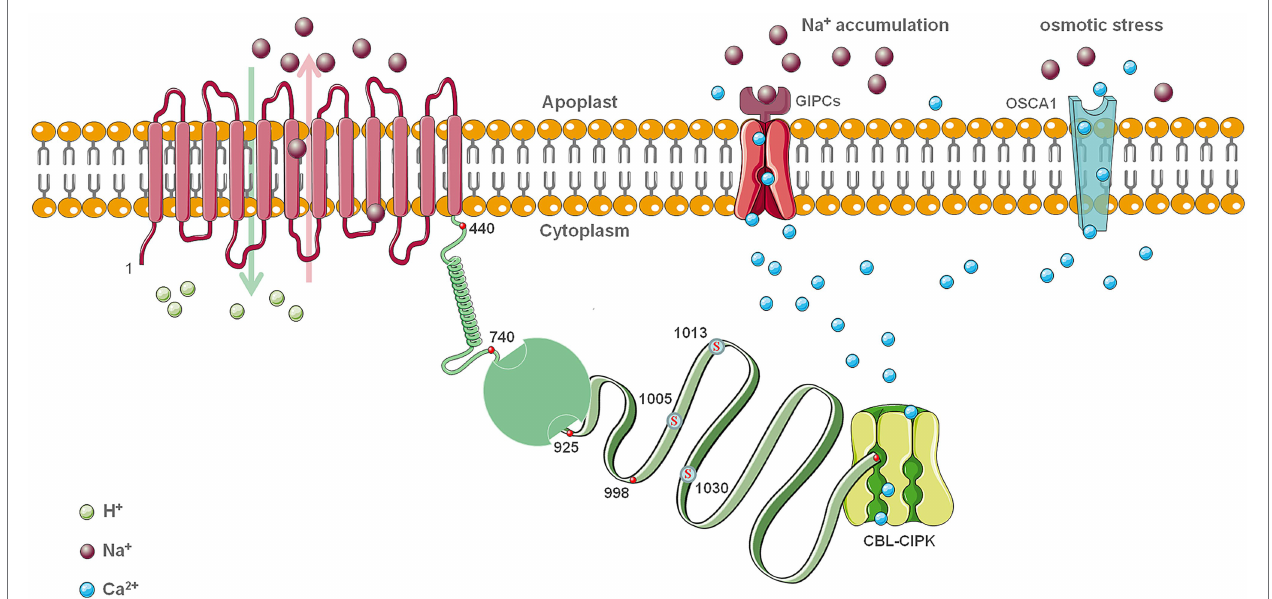
FIGURE 2 | The model structure of SOS1 in salt stress. Based on an analysis of Arabidopsis , the assignment of the 12 transmembrane domains (TMDs; 1–440) was assumed evenly distributed. The region 742–925 is functional activation area and enclosed by the C-terminus (998 –1,146) in the absence of salt stress, and the folded region is the disordered non-conservative region from 925 to 997. The boundaries of these regions should not be considered as consistent for all species. The red mark at the end of C-terminus represents DSPS, a conservative phosphorylation site recognized by the calcineurin B-like protein (CBL)-CIPK protein kinase complexes. Other three serine conservative phosphorylation sites at the C-terminus are also highlighted in red color. Glycosyl inositol phosphorylceramide sphingolipids (GIPCs) function as a Na + receptor and Ca 2+ channel under salt stress. OSCA1 functions as a Ca 2+ channel under osmotic stress. This is still a reference model that needs experimental